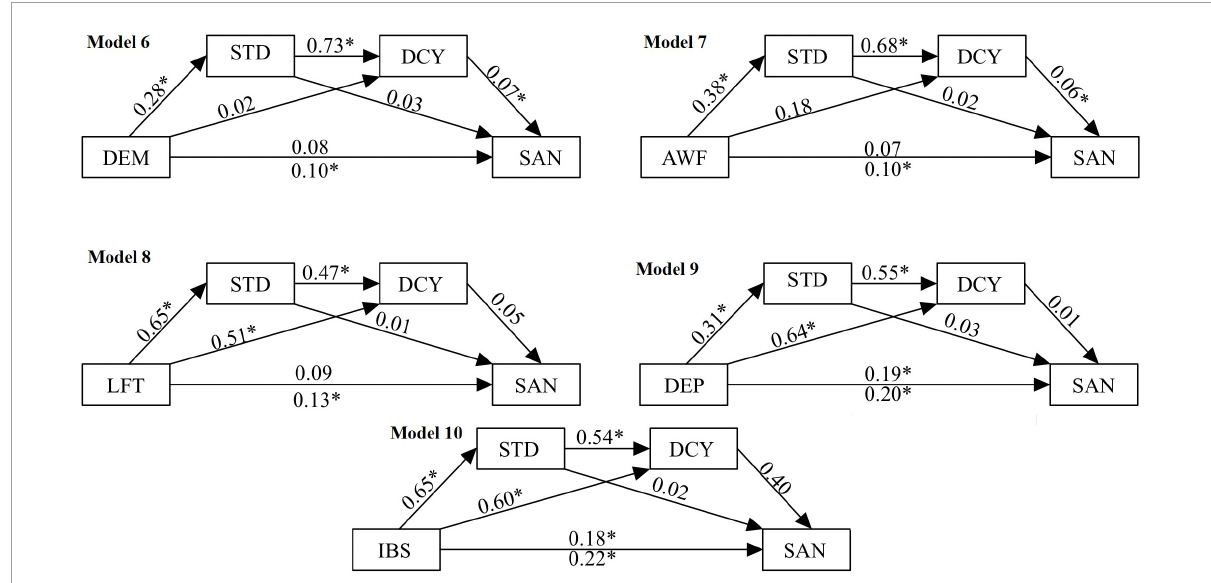
FIGURE3 Regression weights for the SAMM models with irrational beliefs (iPBI), perfectionism (SAPS) and somatic anxiety (CSAI-2). ∗ p < 0.05. DEM, demandingness, LFT, low-frustration tolerance; AWF, awfulizing; DEP, depreciation; IBS, total of irrational beliefs; STD, standards (adaptive perfectionism); DCY, discrepancy (maladaptive perfectionism); SAN, somatic